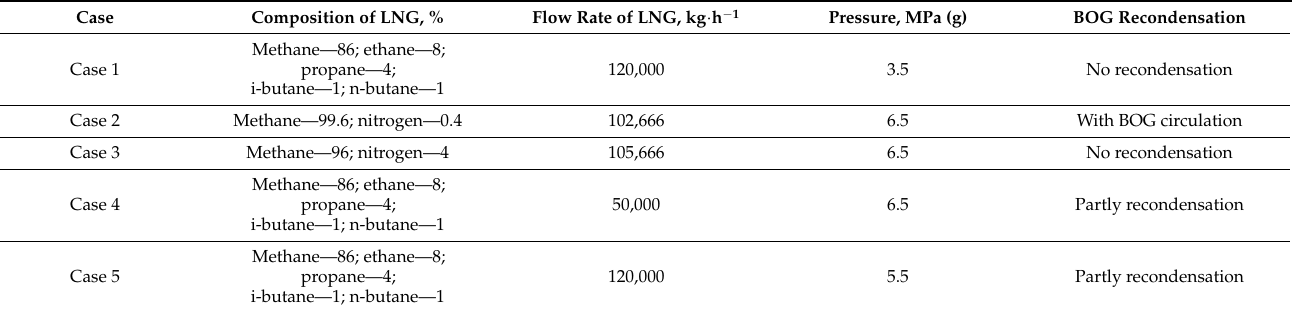
Table 1. Criteria of analysed LNG regasification cases at